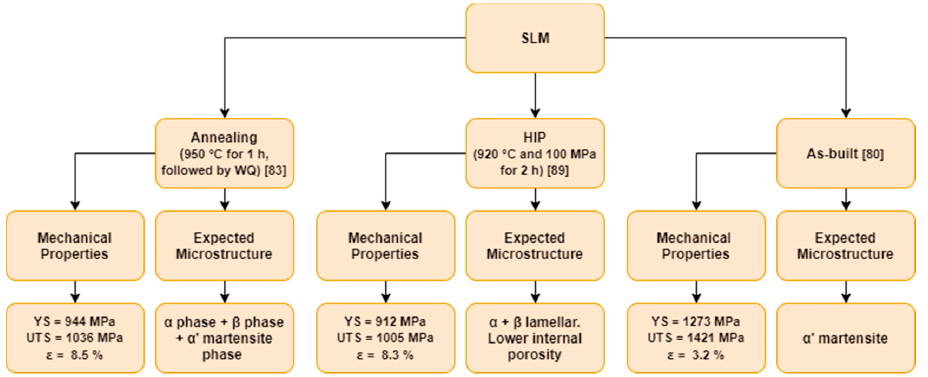
Figure17. Diagramoftheexpectedmicrostructureandmechanicalpropertiesofas-builtandheat-treated Figure 17. Diagram of the expected microstructure and mechanical properties of as-built and heat- SLMed Ti–6Al–4V treated SLMed Ti–6Al–4V samples.